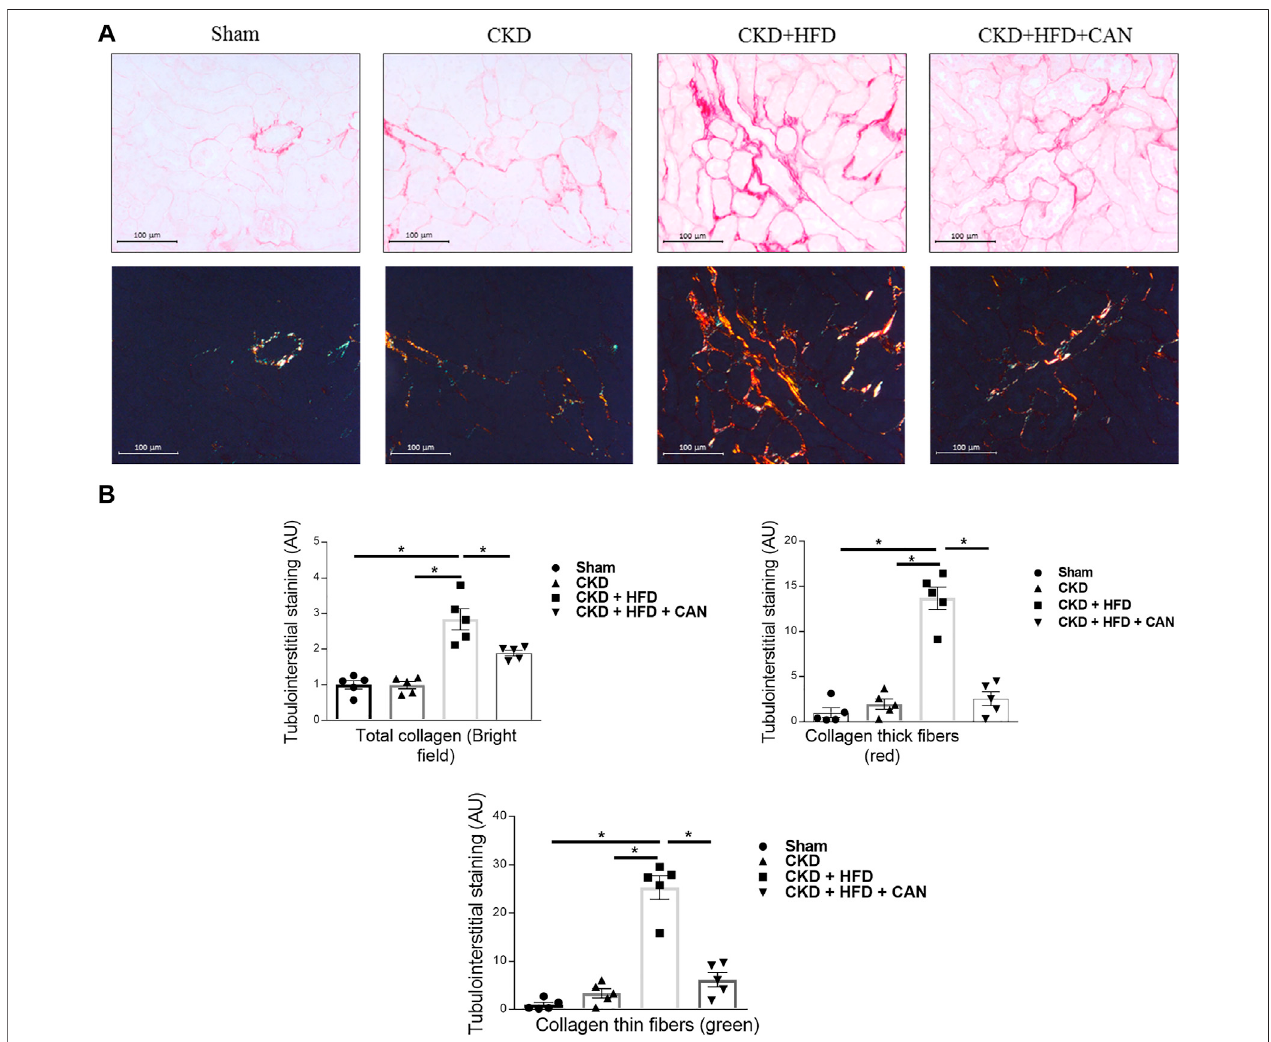
FIGURE 3 | Characterization of the renal injury and effect of the MRA canrenoate. (A) Sirius red staining and collagen fi ber content (bar scale 100 μ m) showing the fi brosis in the kidney of Sham, CKD, CKD HFD and CKD HFD CAN mice and (B) its quanti fi cation. Data represent the mean ± SEM. Statistical analysis by one-way ANOVA; with Tukey post-test * p < 0.05 n = 5 –